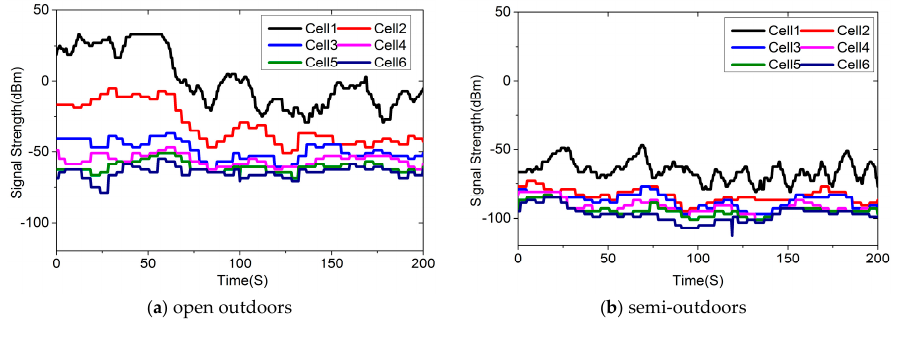
Figure 6 . Cont. Figure 6.